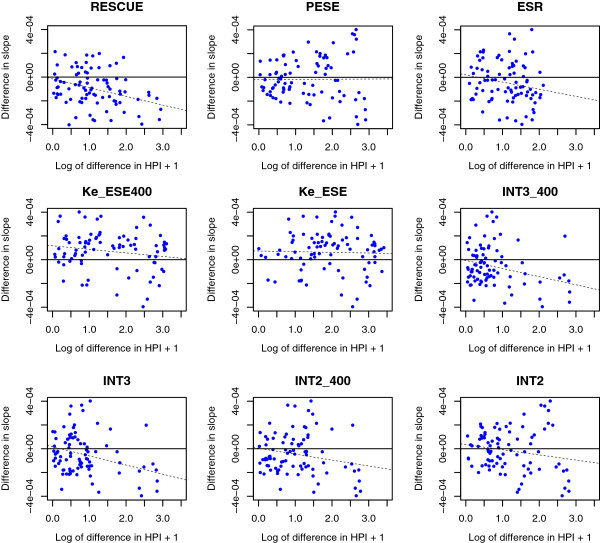
The ability of each set of ESEs to predict trends in relative synonymous codon usage. We plot the difference in HPI versus the difference in slope of codon usage, as one approaches a boundary for all pairs of synonymous codons. A negative slope implies a codon is enriched near boundaries. Thus we expect those codons with a high HPI to have a more negative slope. Thus we expect a large difference in HPI to be reflected in a large negative difference in slope between two synonymous codons.